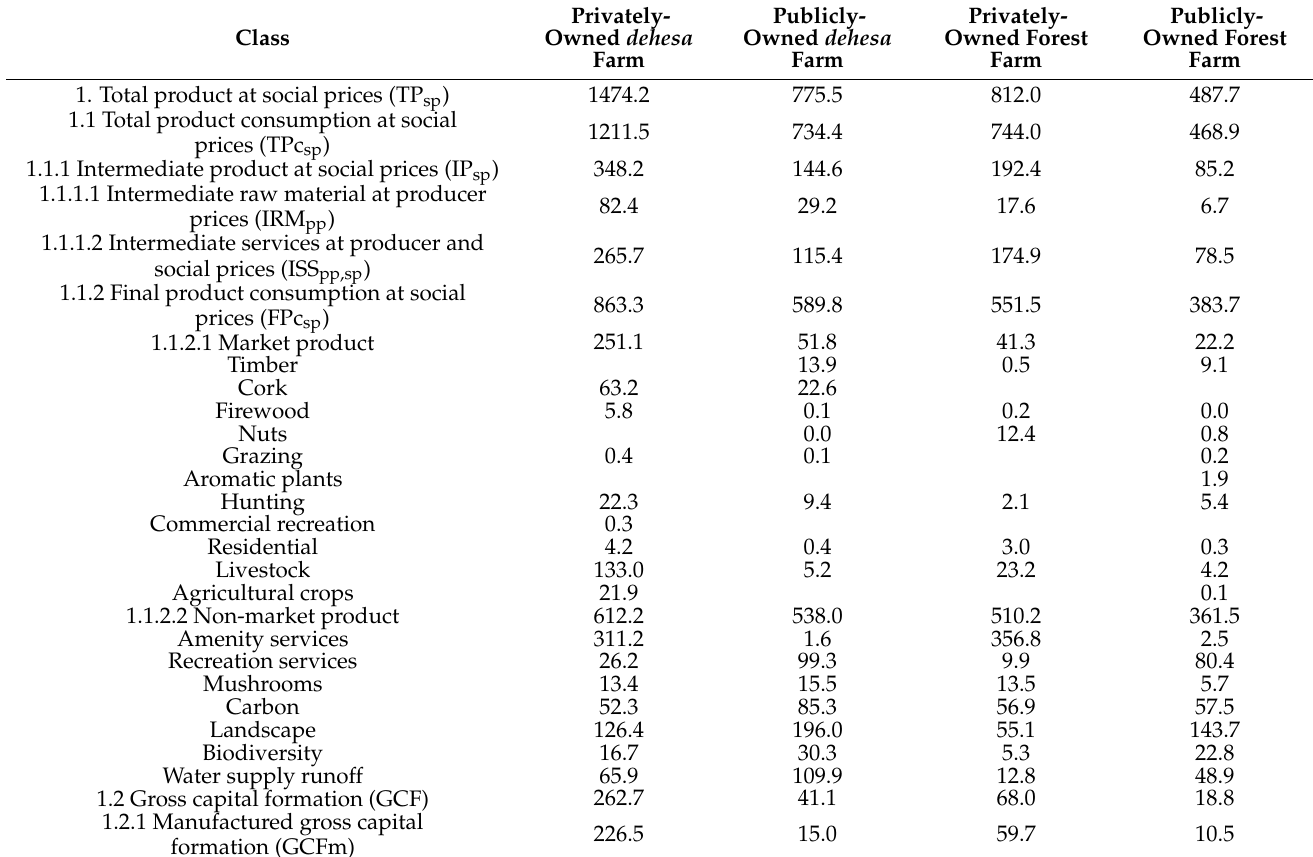
Table 3. Production and income generation account of case-study large dehesa and forest farms in Andalusia under the AAS (2010: € /ha). Class